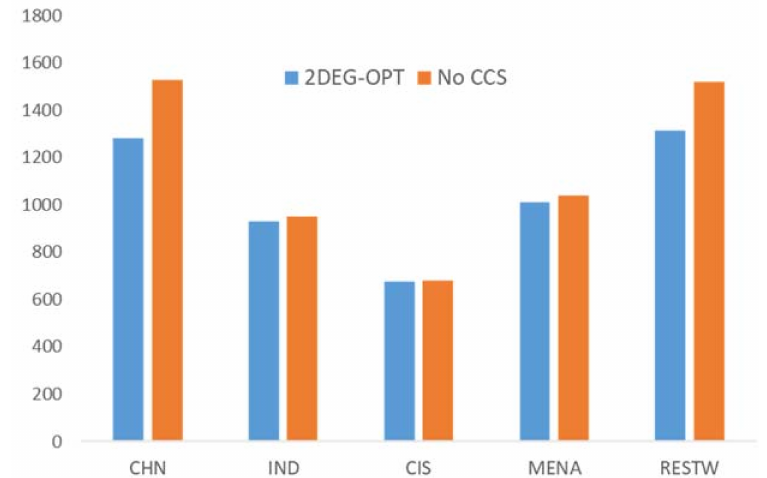
Figure 3. CO 2 emissions of developing regions in 2050 (in Mt CO 2